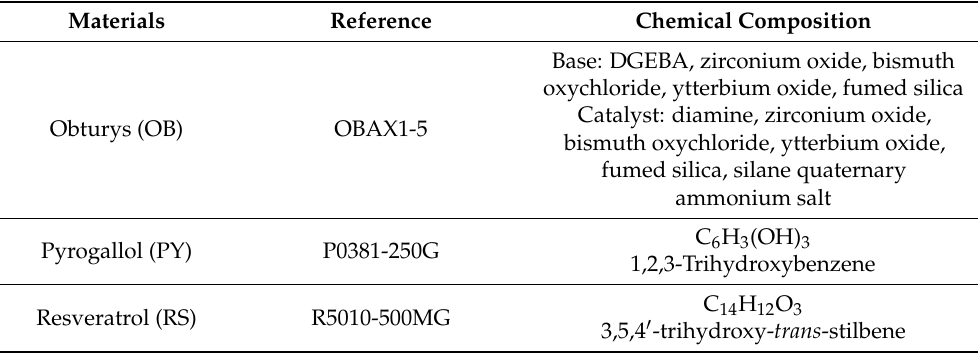
Table 1. Endodontic sealer and polyphenols: chemical compositions and references. Materials